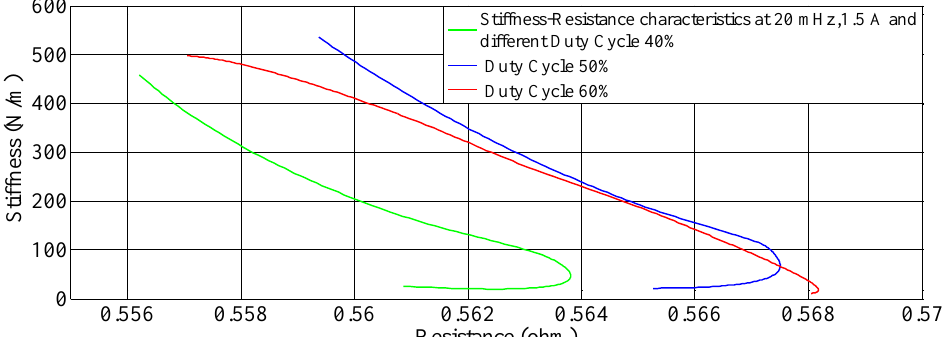
Figure 17. Stiffness response at different duty cycles.